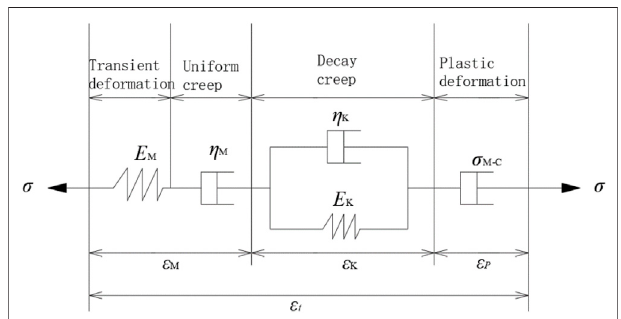
FIGURE 1 | Cvisc viscoelastic-plastic model.